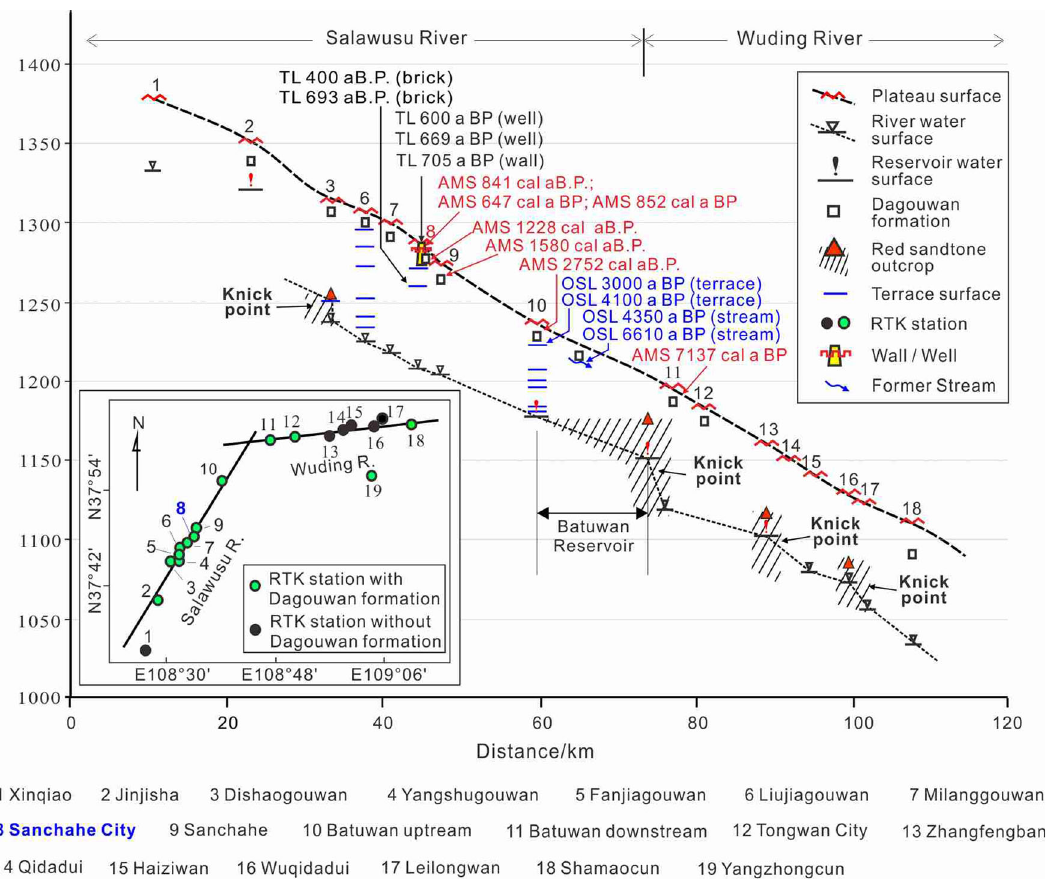
Fig. 5 Sequential and longitudinal pro fi les of the Salawusu and Wuding Rivers. Knickpoints formed in Cretaceous red sandstone, chronological dating, the Dagouwan formations and stream terraces along the longitudinal pro fi le of the Salawusu and Wuding